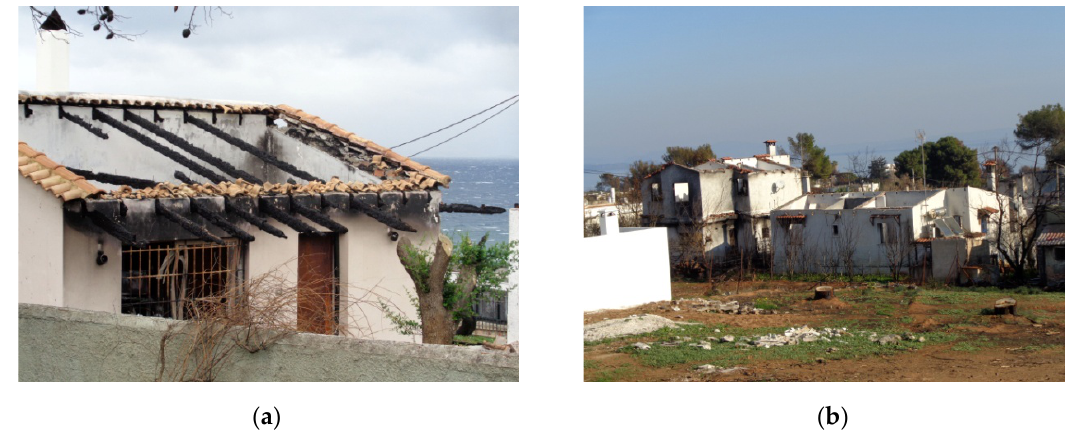
Figure 7. (a, b) Photographs presenting damage that occurred in wooden roofs after the wildfire in Mati.